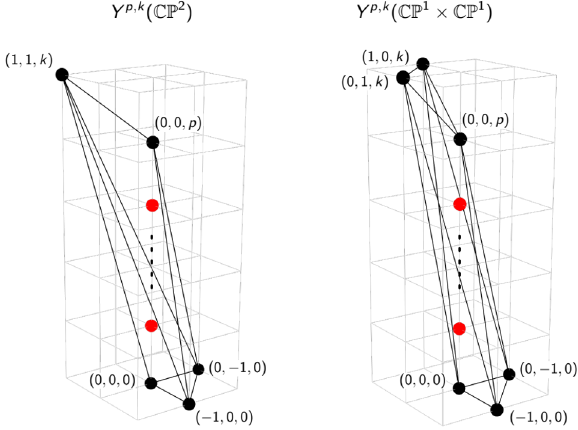
Figure 3 . Toric diagrams corresponding to the Y p,k ( CP 2 ) and Y p,k ( CP 1 × CP 1 ) families of toric Calabi-Yau